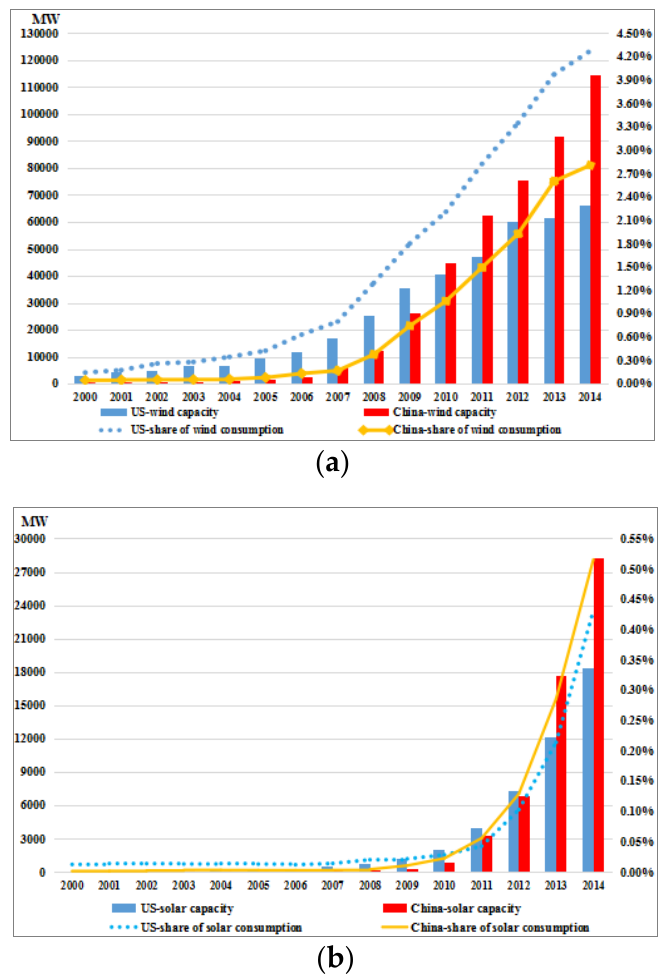
Figure 6. Cont . Figure 6. Comparison of ( a ) wind power and ( b ) solar power between China and the US.